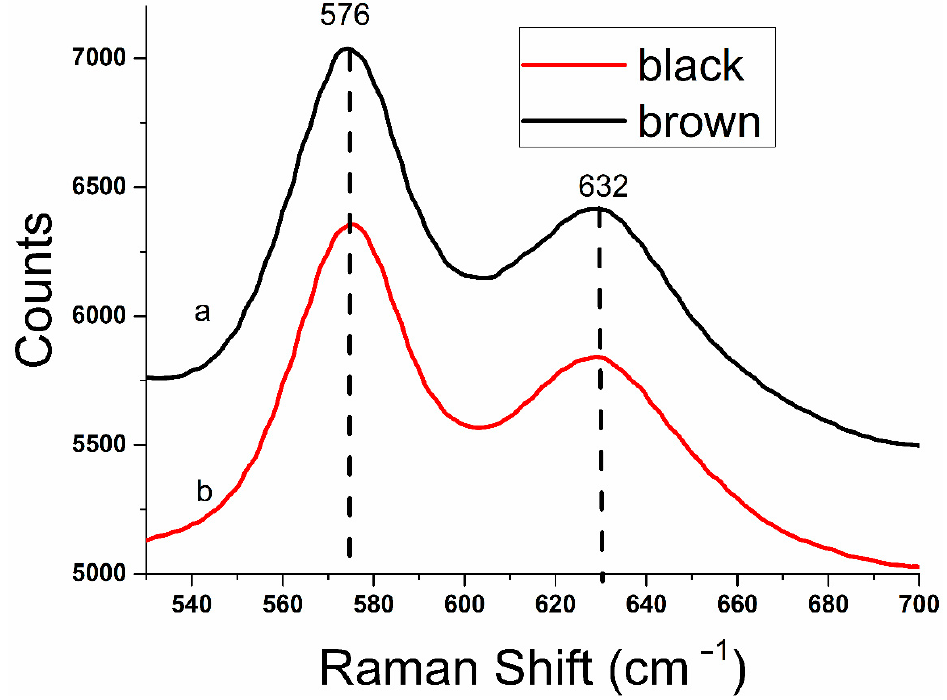
Figure 3. Raman spectra of black ( a ) and brown α -MnO 2 ( b ).